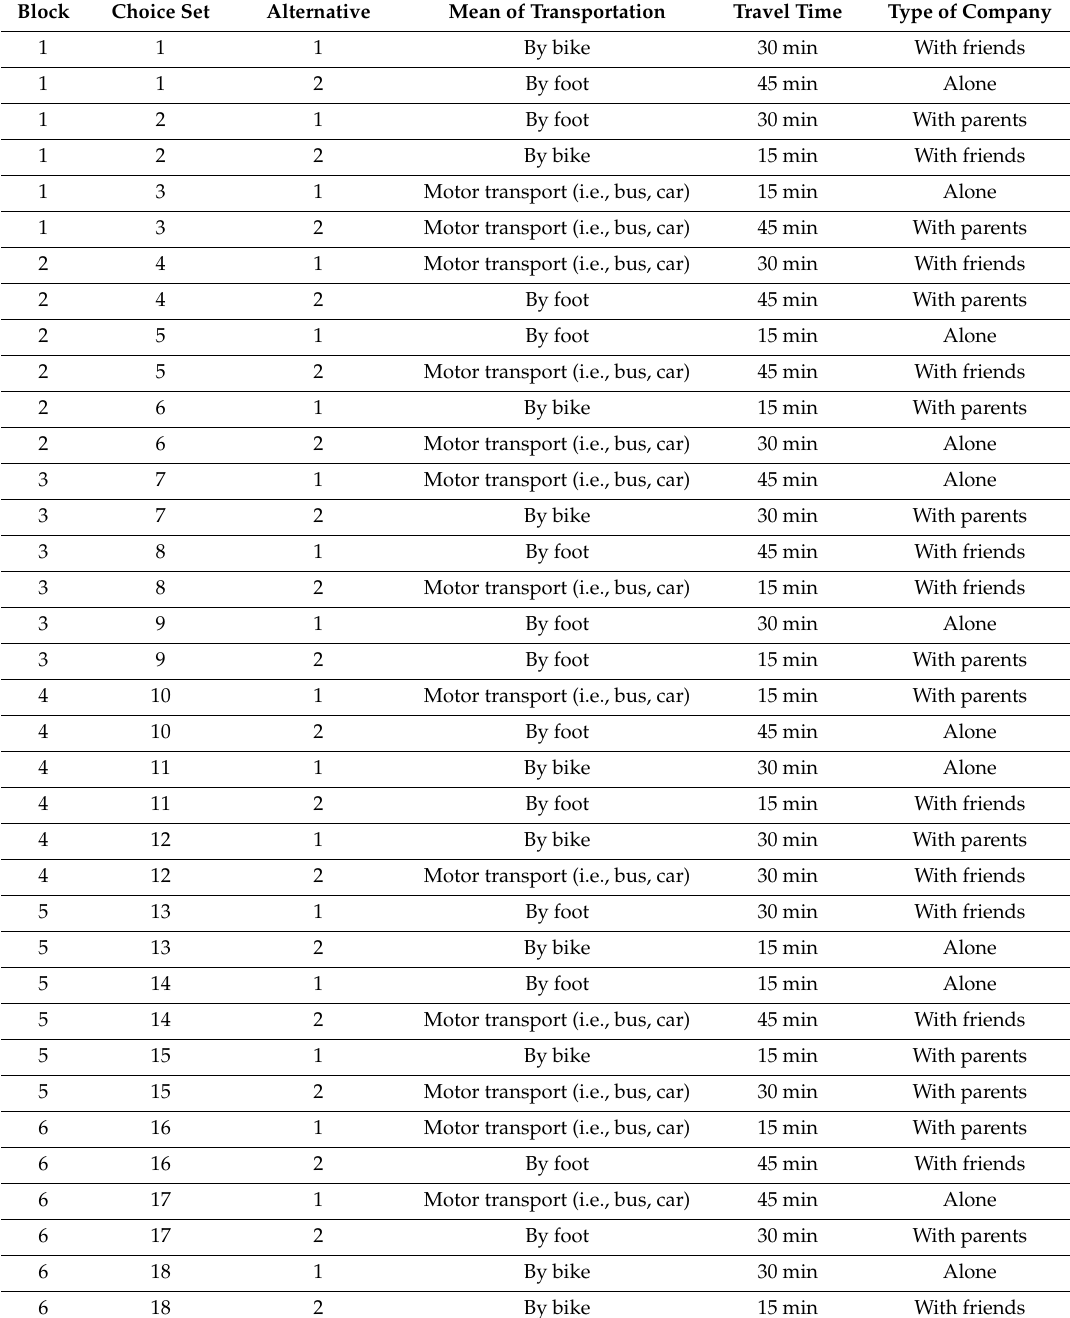
Table A2. Blocks, choice sets and alternatives of the discrete choice